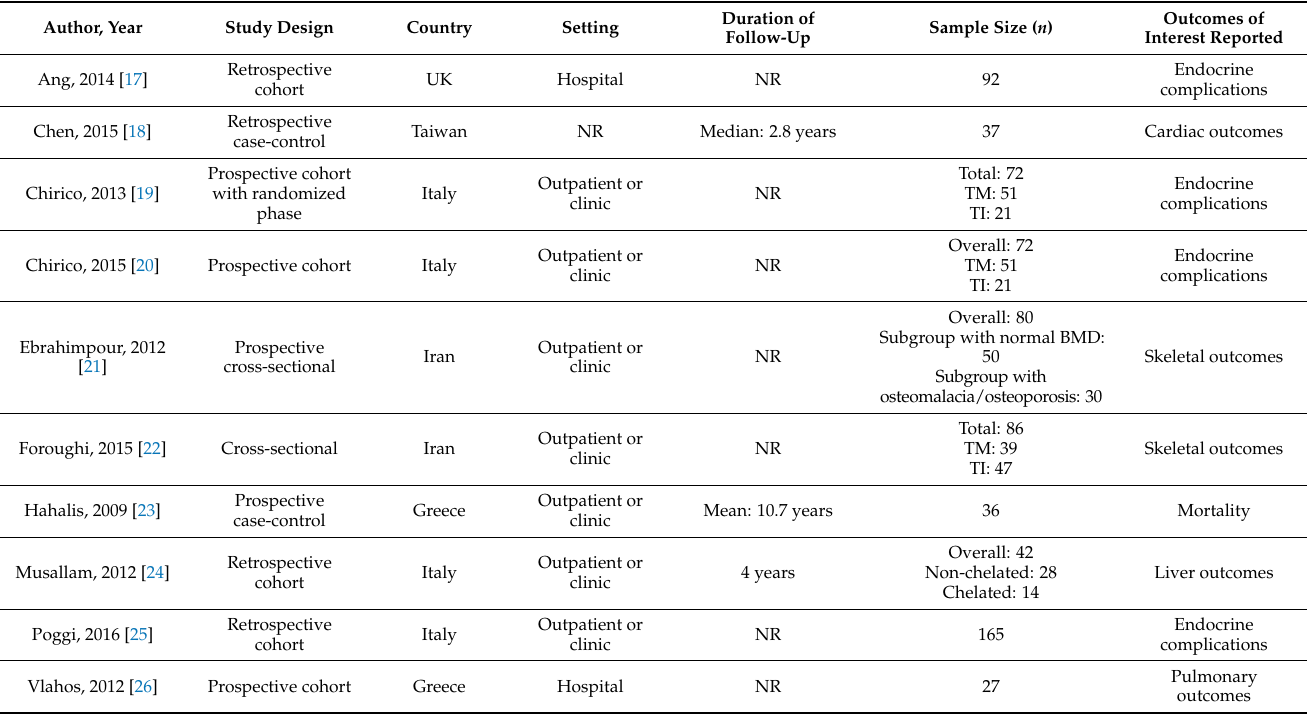
Table 1. Study characteristics of β -thalassemia